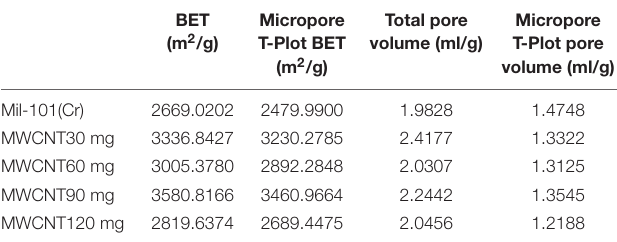
TABLE 3 | Pore performance data (BET) of carbon nanotube-mil-101 (Cr)